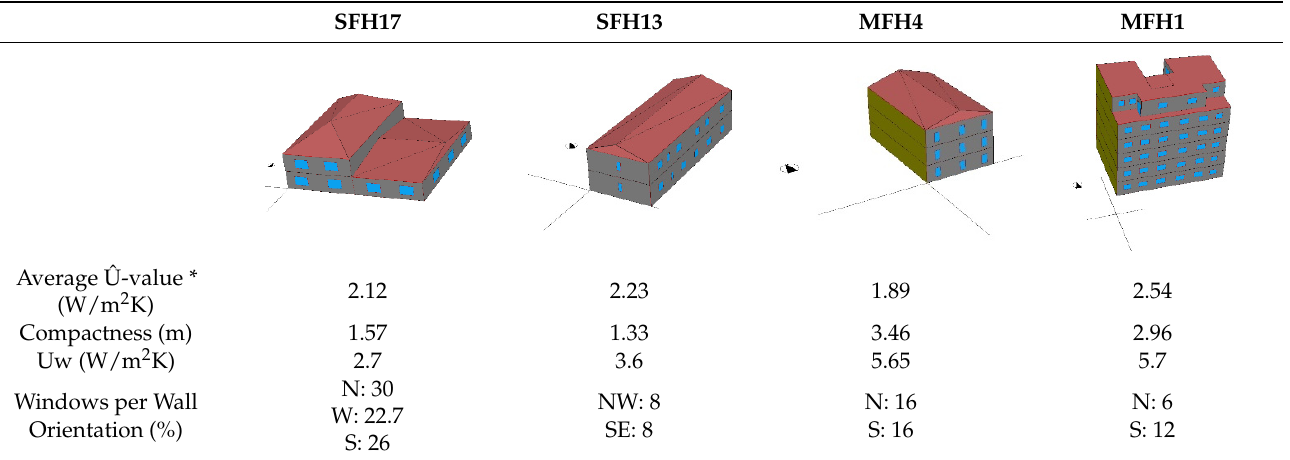
Table 1. Reference buildings characteristics.